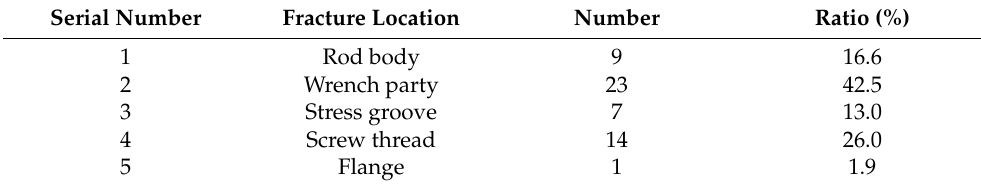
Table 3. Fatigue fracture position